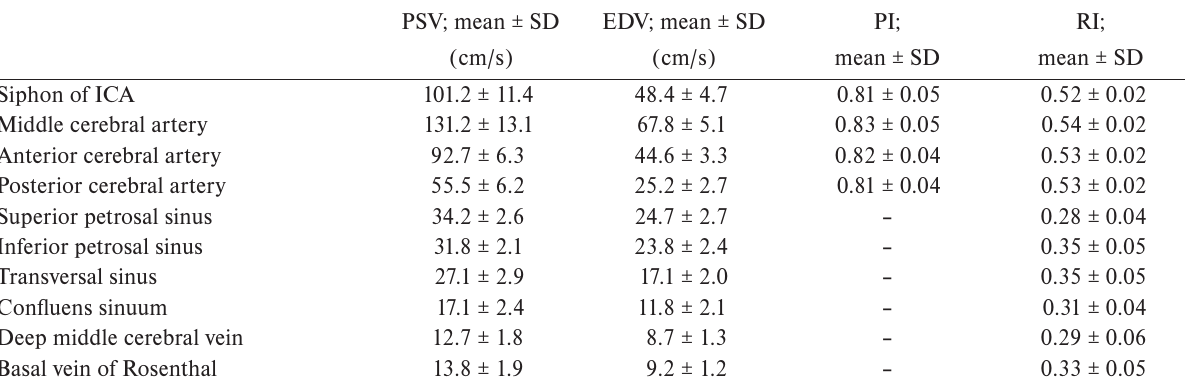
Table 2. Blood flow parameters measured from transtemporal approach using non-contrast enhanced TCCS.